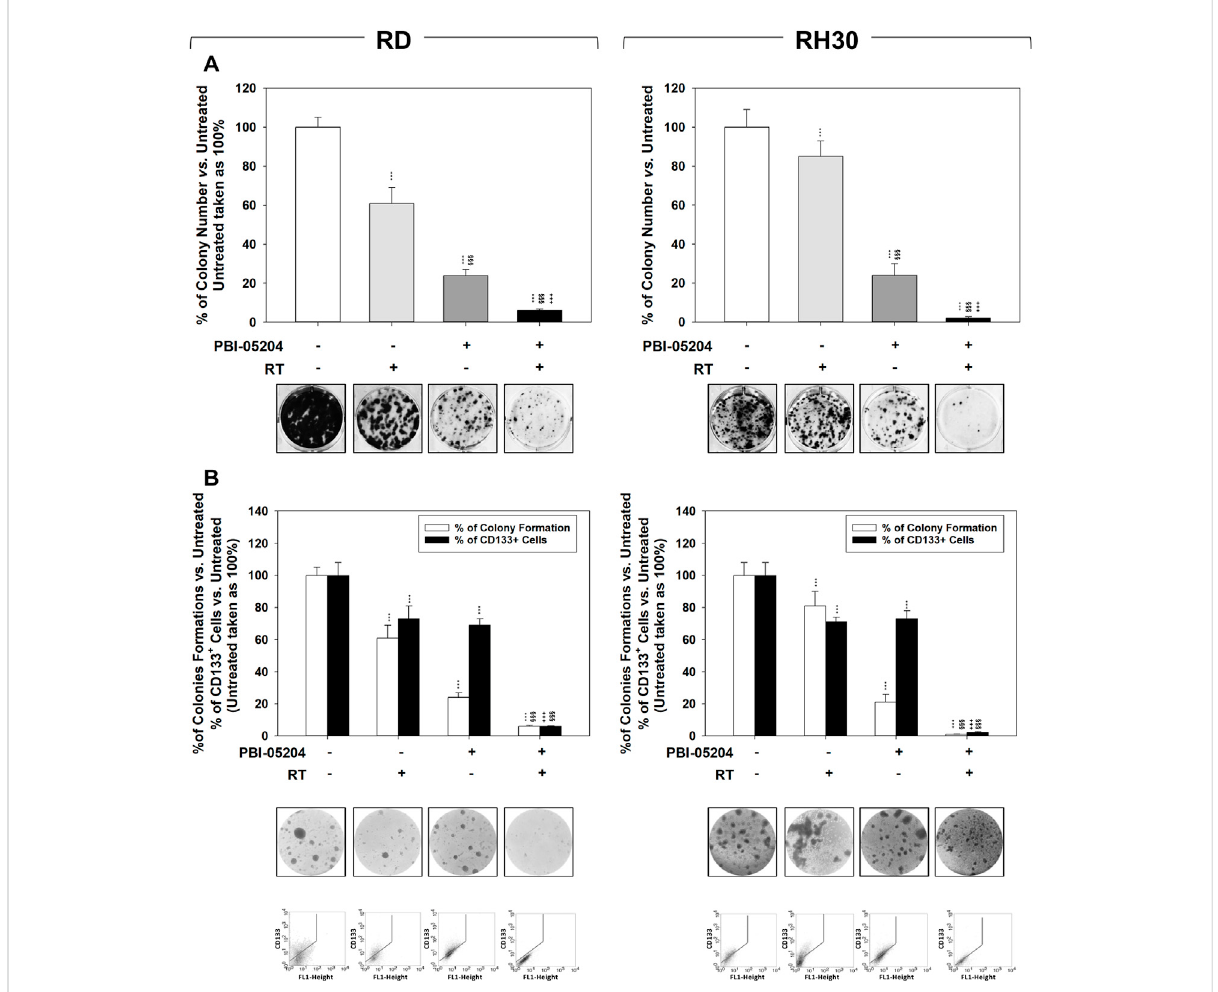
FIGURE 5 PBI-05204 radiosensitizes FN-RMS and FP-RMS cell lines and cancer-stem like derived cells. (A) Colony formation assay of RD (Left) and RH30 (Right) treated with PBI-05204 IC 50 , RT alone or with the combination. Three h after RT (4 Gy), cells were seeded at low concentrations for colony assays. Colony forming ef fi ciency was calculated by crystal violet absorbance after 14 d of PBI-05204 treatment. (B) The formation of spheres enriched instem-like cellsandtheexpressionofCD133 wereassessed inRD(Left)andRH30 (Right)treated withPBI-05204 (IC50),RTalone or with the combination. Results represent the mean values ±SD of three independent experiments (Up). Representative data from three independent experimentsisshown(Down).Statisticalsigni fi cance:* p ≤ 0.05,** p ≤ 0.01,*** p ≤ 0.001,vs.Untreated, § p ≤ 0.05,§§ p ≤ 0.01,§§§ p ≤ 0.001 vs.RT,+ p ≤ 0.05, ++ p ≤ 0.01, +++ p ≤ 0.001 vs.